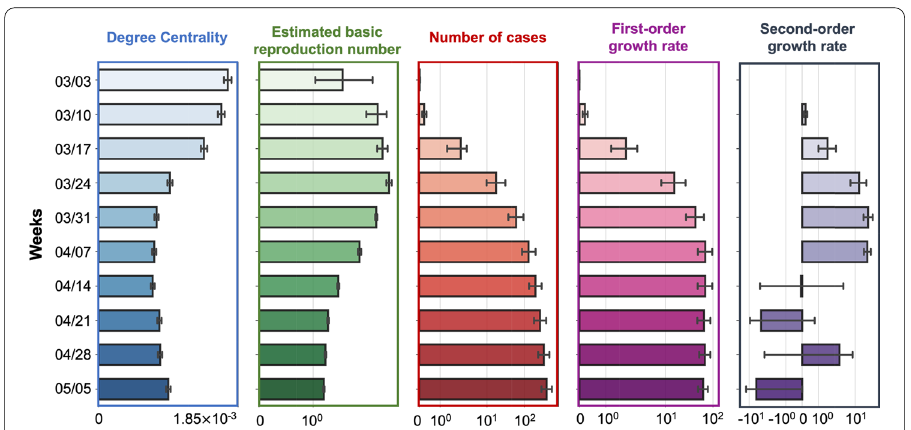
Fig. 2 Five metrics for measuring population co-location and COVID-19 situation over time: co-location degree centrality, estimated basic reproduction number, number of cases, first-order growth rate, and second-order growth rate